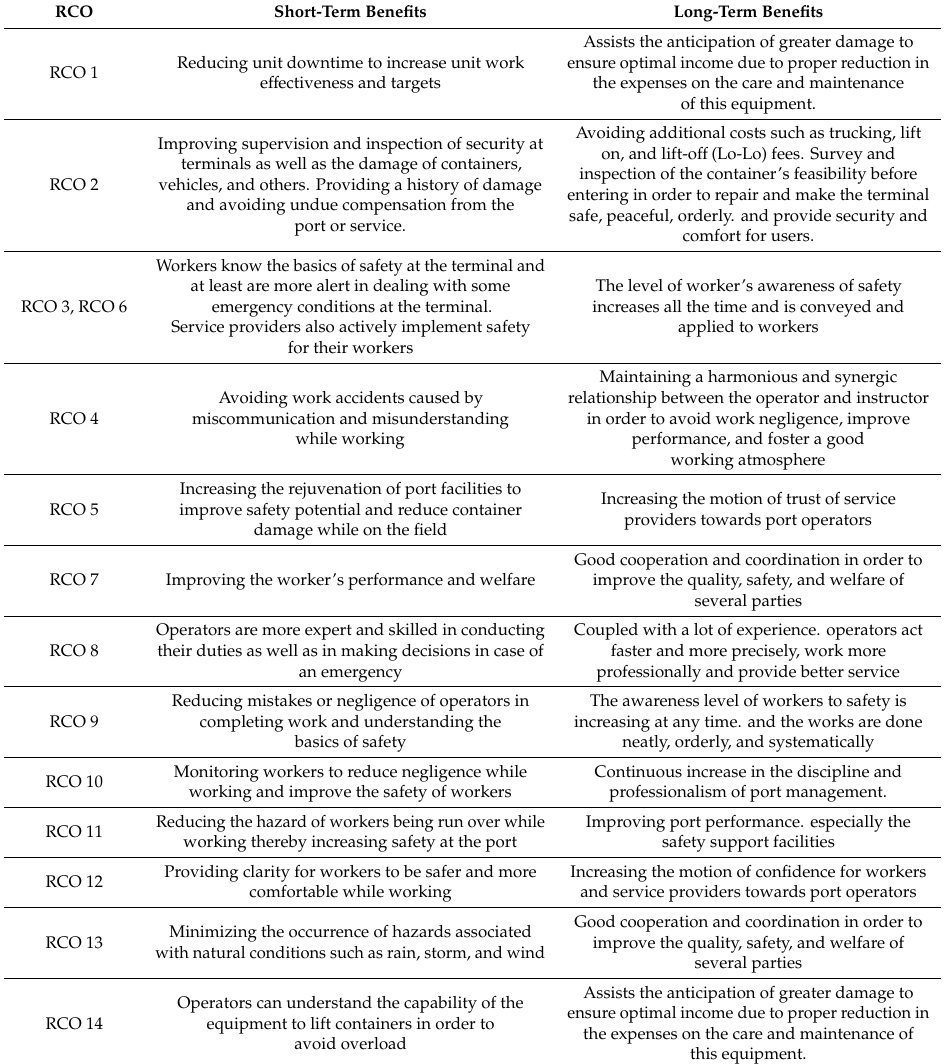
Table 14. Benefits of the Risk Control Option